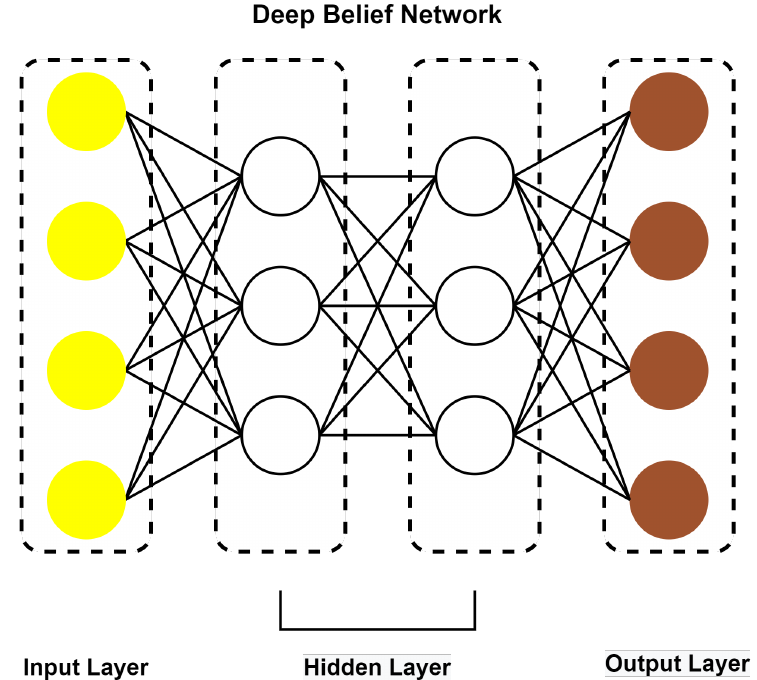
Figure 6. The general structure of a deep belief network.